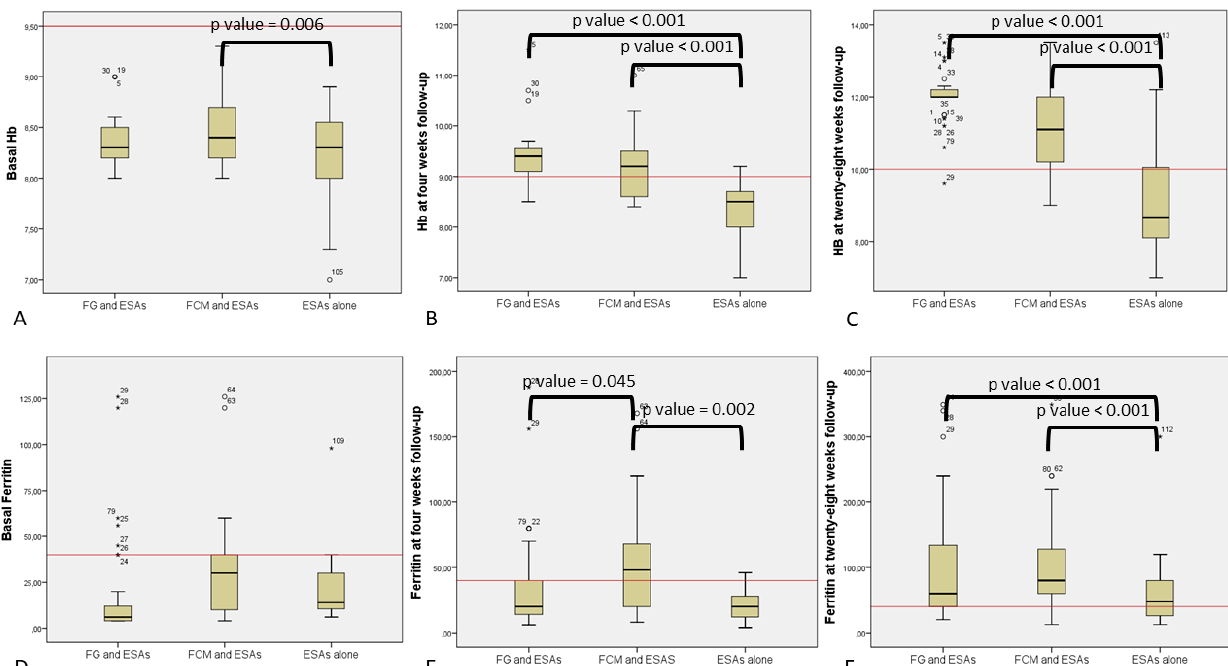
Figure 1. Comparison of patient’s hemoglobin and ferritin based on different treatments: ( A ) Basal hemoglobin (Hb) in ferric gluconate (FG) and erythropoiesis-stimulating agents (ESAs); ferric car- boxymaltose (FCM) and ESAs; and ESAs alone. Continuous red line represents the clinical cut-off for enrollment (9.5 g/dL). ( B ) Hb at four weeks follow-up in FG and ESAs; FCM and ESAs; and ESAs alone. Continuous red line is the clinical cut-off for group comparison (9.5 g/dL). ( C ) Hb at 28 weeks of follow-up in FG and ESAs; FCM and ESAs; and ESAs alone. Continuous red line represents the clinical cut-off for group comparison (10 g/dL). ( D ) Basal ferritin in FG and ESAs; FCM and ESAs; and ESAs alone. Continuous red line represents the clinical cut-off for group comparison (40 ng/mL). ( E ) Ferritin at four weeks of follow-up in FG and ESAs; FCM and ESAs; and ESAs alone. Continuous red line represents the clinical cut-off for group comparison (40 ng/mL). ( F ) Ferritin at 28 weeks follow-up in FG and ESAs; FCM and ESAs; and ESAs alone. Continuous red line represents the clinical cut-off for group comparison (40